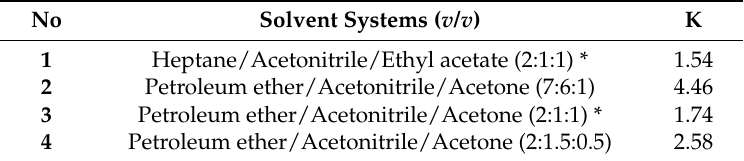
Table 2. The partition coefficients values for β -elemene in different solvent systems.